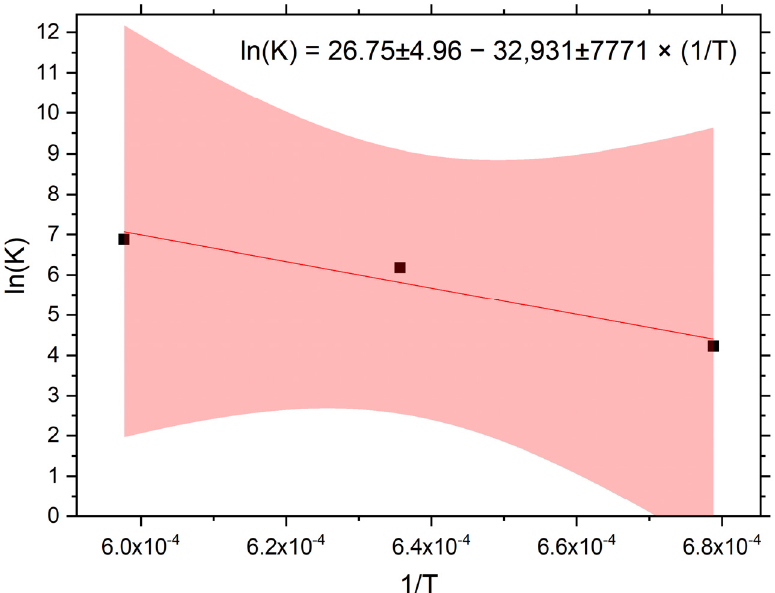
Figure 6. Linear regression of K dependency on inverse temperature with 95% confidence intervals. The fitted values are shown in the equation together with standard errors.